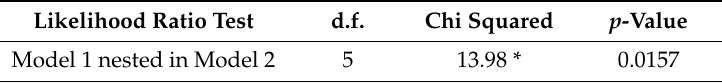
Table 7. Likelihood ratio test for model comparison of fit, with degrees of freedom (d.f.), chi-squared statistic and p